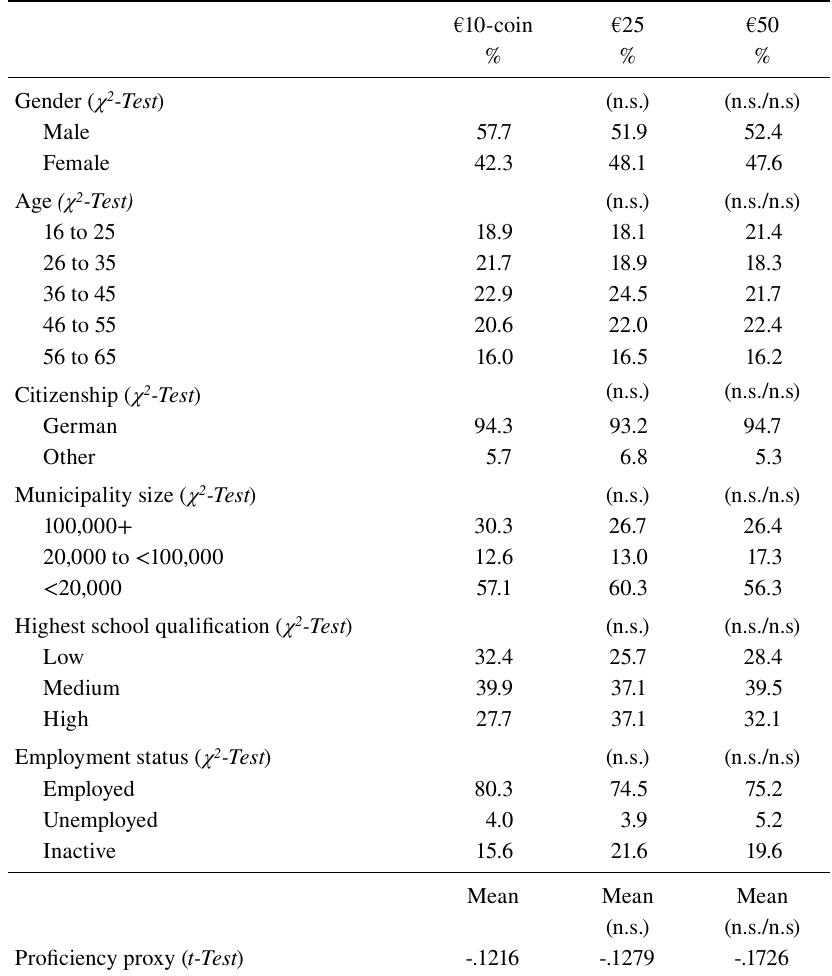
Table 4 Comparison of survey estimates across incentive treatments